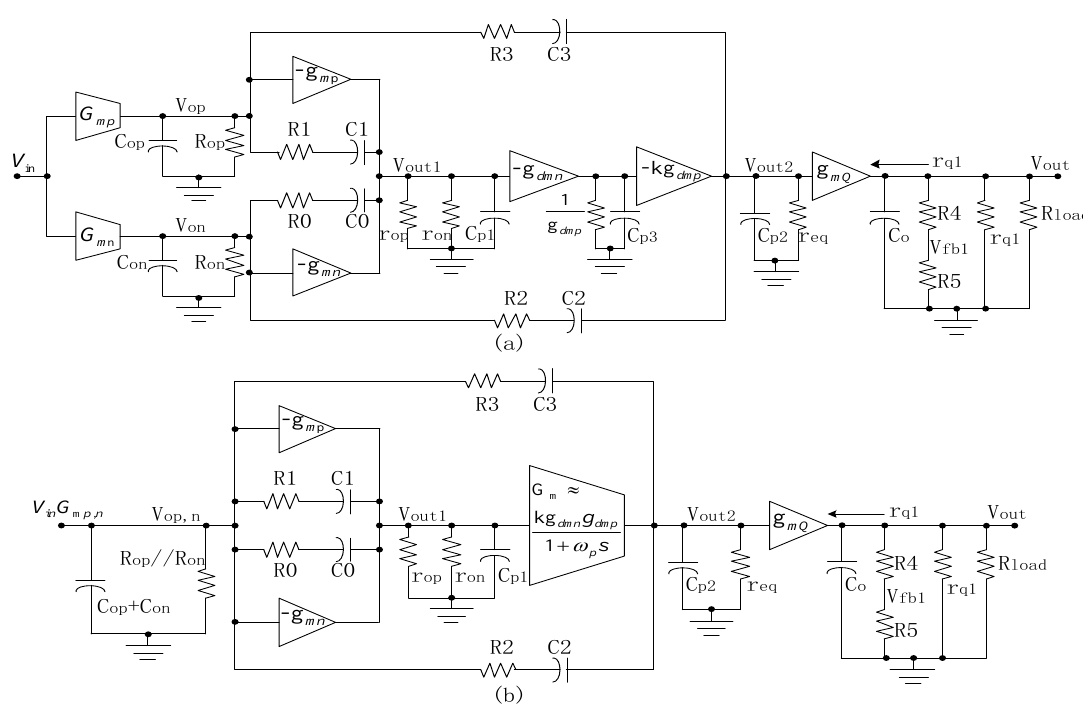
Figure 5. ( a) Small-signal model of the proposed linear regulator core; ( b ) simplified small-signal